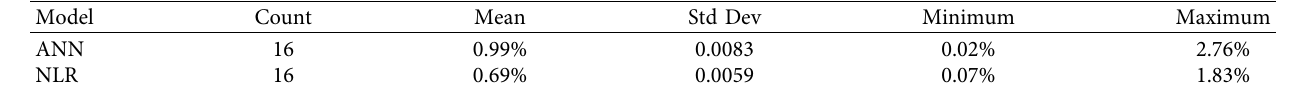
Table 6: Error statistics with ANN and NLR.